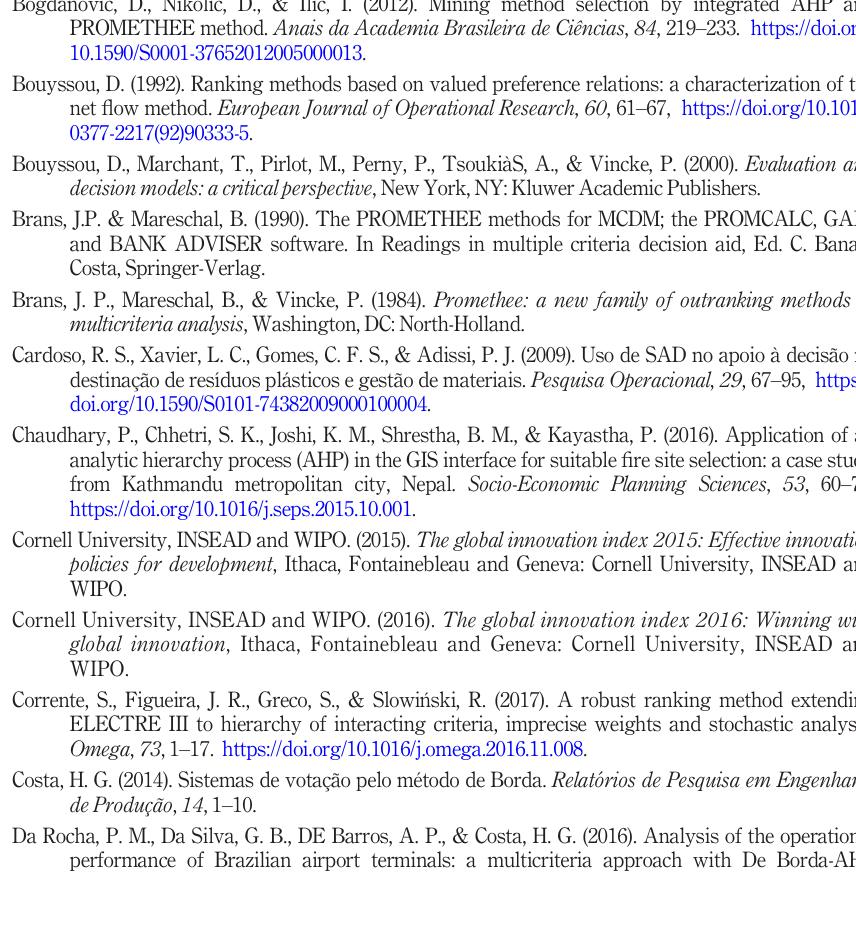
Table 11. Re-organized subset of countries for